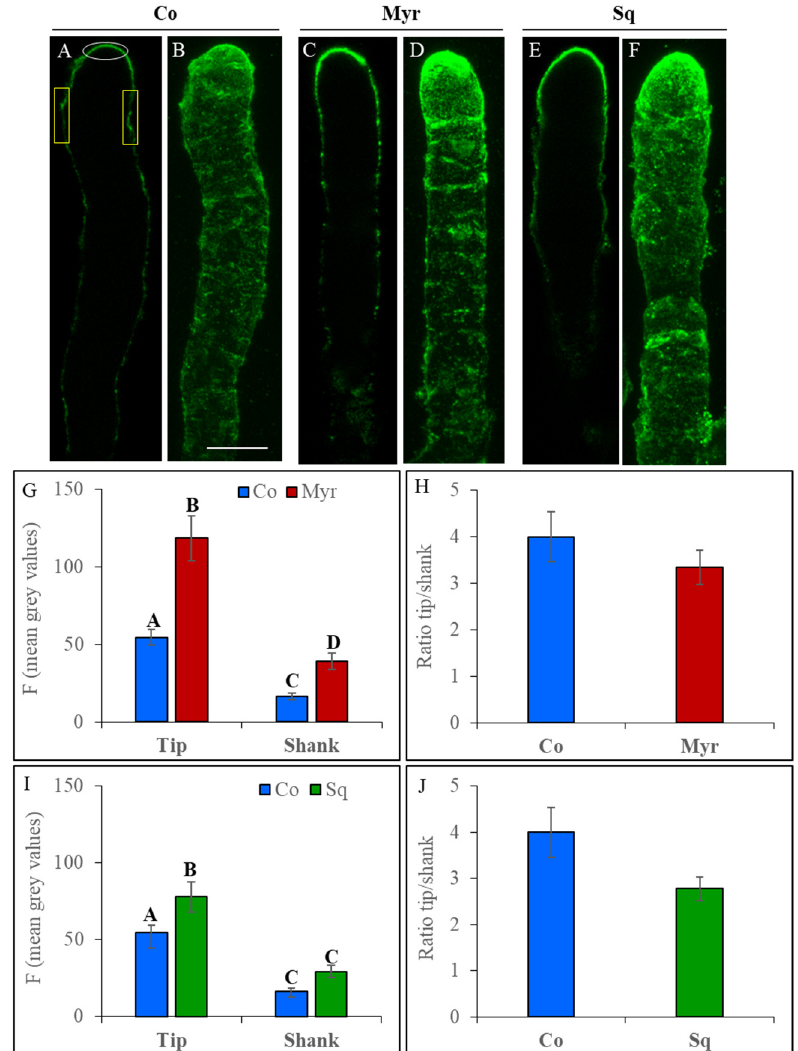
Figure 4. Effect of myriocin and squalestatin on pectin secretion. Distribution of methyl-esterified pectins was determined by labelling with JIM7 antibody in control ( A , B ), myriocin- ( C , D ) and squalestatin- ( E , F ) treated pollen tubes. Medial plane ( A , C , E ) and whole reconstruction ( B , D , F ) are shown. Quantification of fluorescence intensity in tip and shank (white and yellow ROIs, respectively, as specified in panel ( A ); n > 11) performed using ImageJ showed that myriocin and squalestatin induced an increase in esterified pectins in these regions (( G , I ); tip ANOVA and Tukey’s post hoc test: p < 0.0001 for Myr and p < 0.01 for Sq; shank ANOVA and Tukey’s post hoc test: p < 0.05 for Myr and p > 0.05 for Sq). The difference in esterified pectins between tip and shank is maintained in pollen tubes grown in the presence of inhibitors ( H , J ). Scale Bar = 10 μ m.